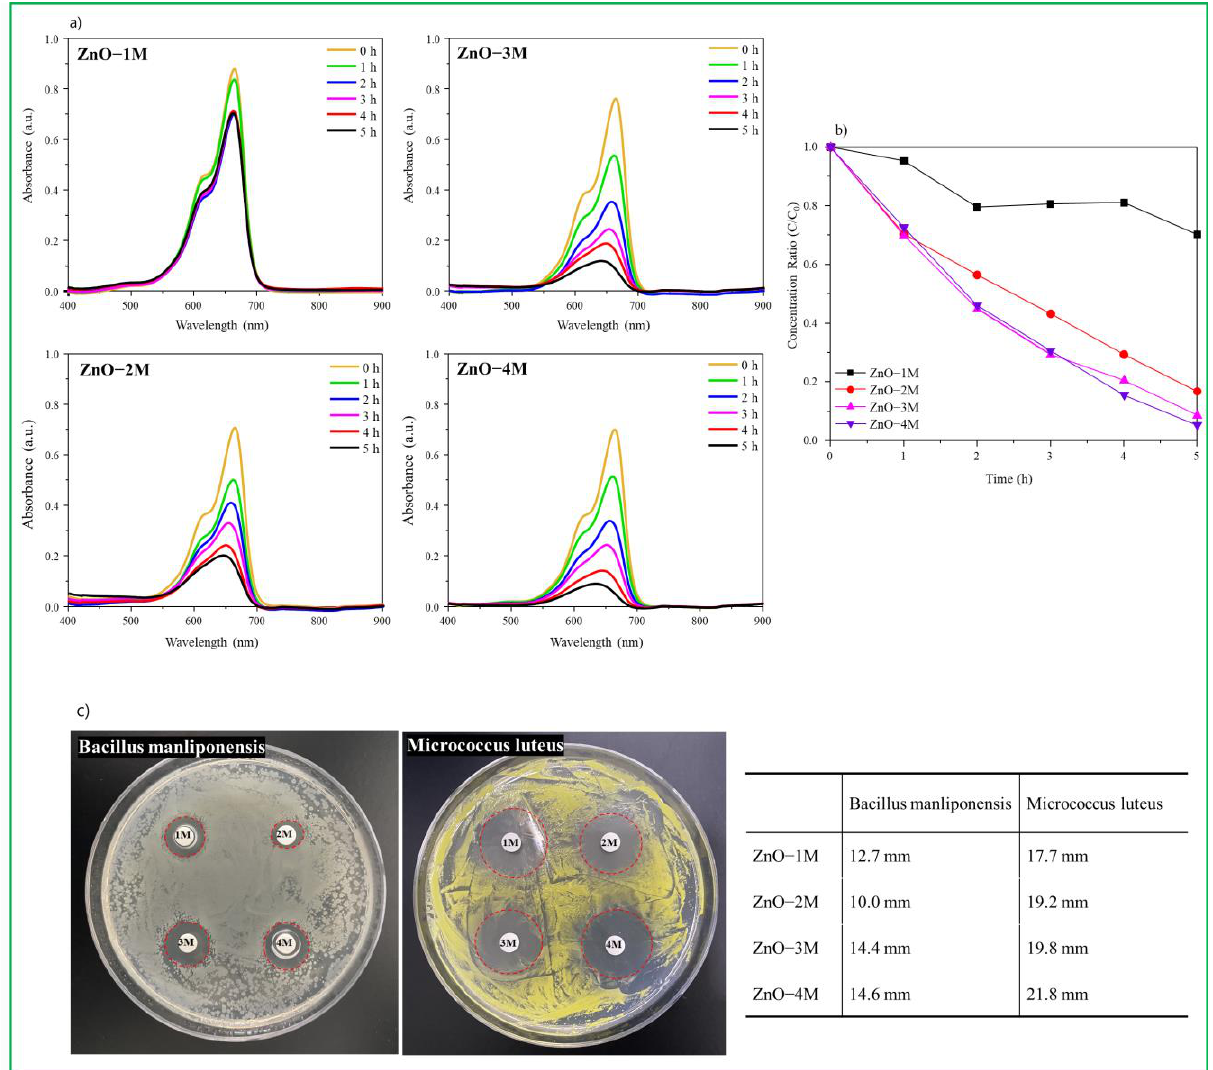
Figure 4. ( a ) UV-visible absorption intensity of MB decomposed with time. ( b ) Photodegradation performance of MB dye according to the catalyst; ( c ) antibacterial ability (zone of inhibition) against B. manliponensis and M. luteus bacteria on each catalyst. Inset table shows the antibacterial activity.